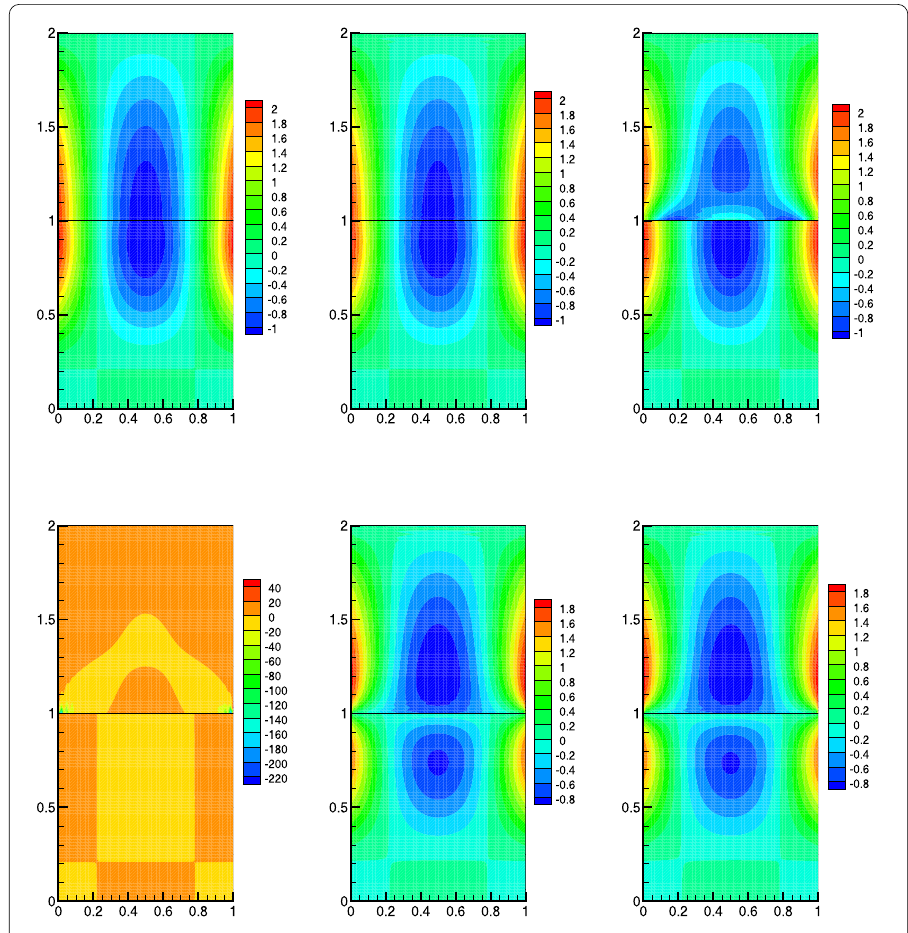
Figure 4 An illustration of the pressure contour for the true solution and approximate solution with the different values of the stabilization parameter: true solution (top-left); δ = 0.1 (top-middle); δ = 1 (top-right); δ = 1000 (down-left); δ = 0.0001 (down-middle); δ = 0 (down-right)